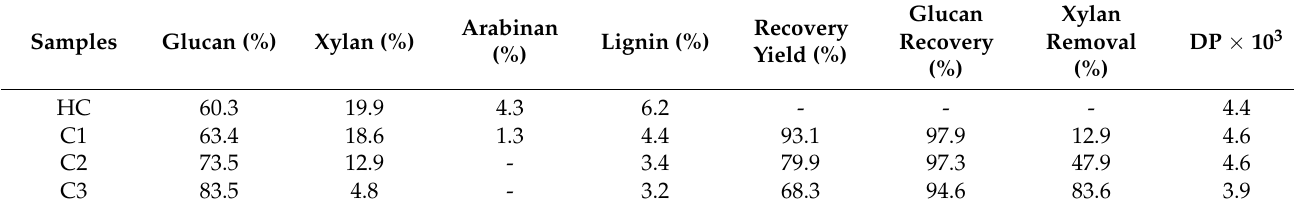
Table 1. Chemical compositional analyses and DP calculations of HC powders before and after HTP at 120 ◦ C (C1), 150 ◦ C (C2), and 180 ◦ C